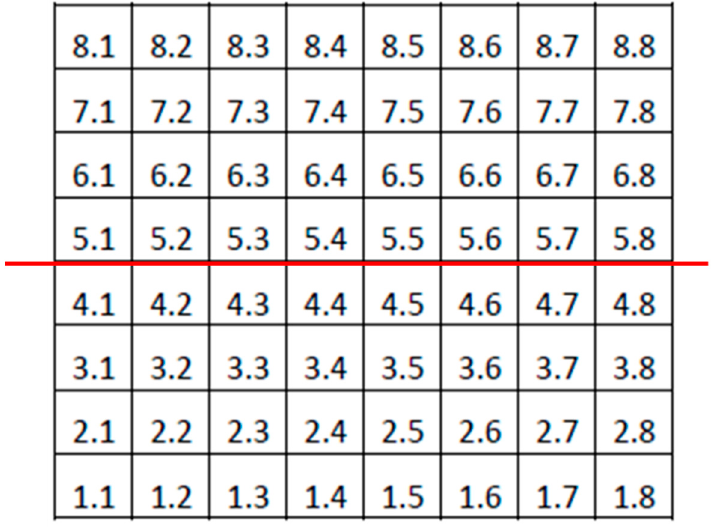
Figure 3. Denomination of cells or superpixels in the 8 × 8 Posterior Pole Algorithm (right eye). The horizontal red line divides the grid into superior and inferior hemispheres. Mean thicknesses of both hemispheres were calculated in this study by averaging the thickness values of the superpixels in each hemisphere.